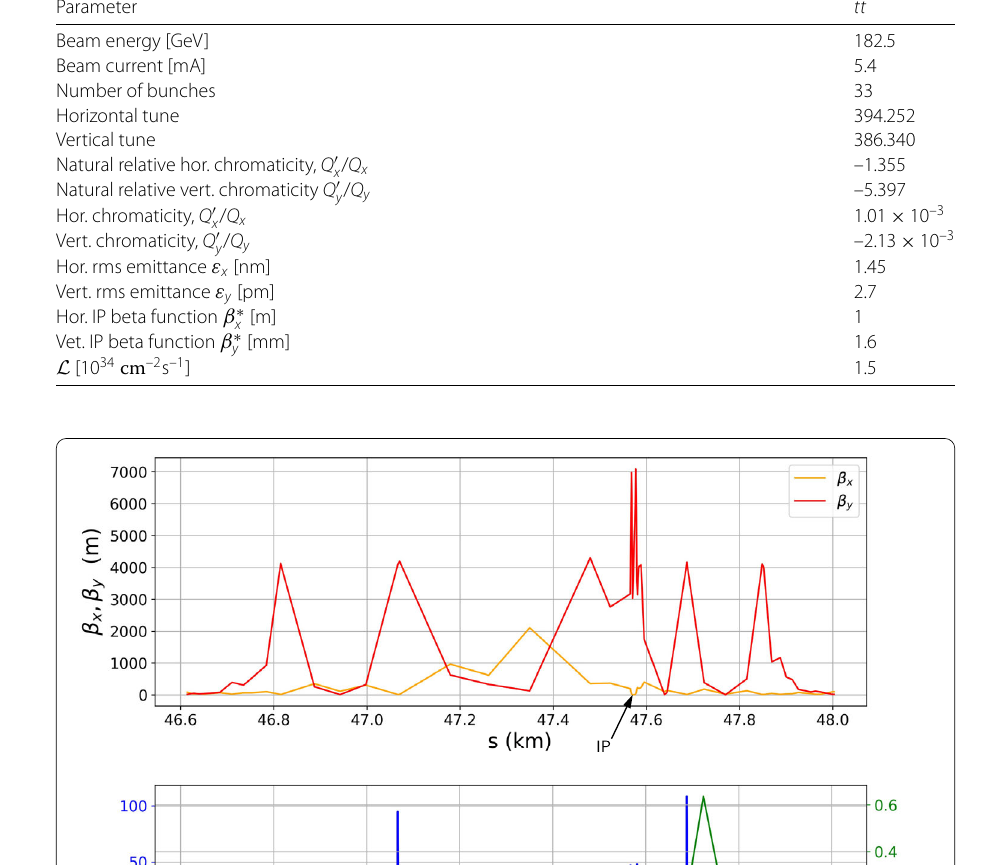
Table 1 Baseline beam parameters for the FCC-ee ttbar lattice with two Interaction Points [1] Parameter